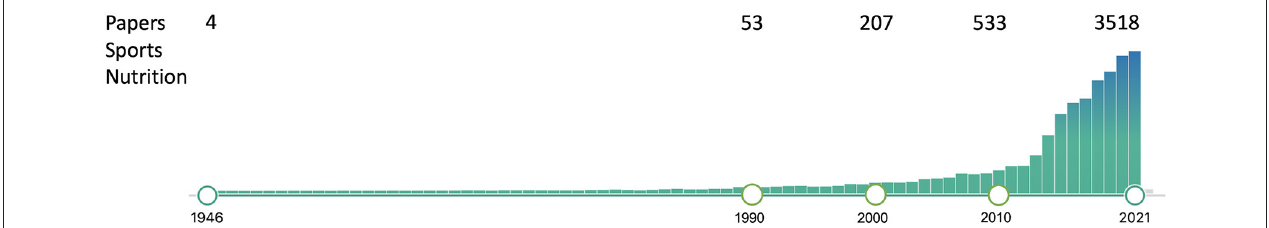
FIGURE 1 | Publications in Pubmed using the search term “Sports Nutrition” as of December, 2021 1 .